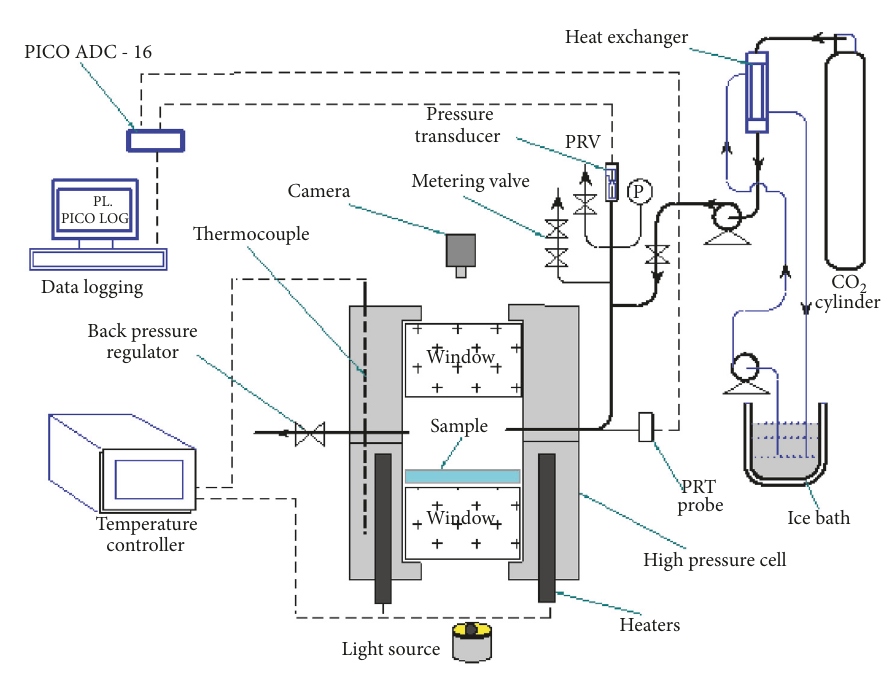
Figure 1: Experimental set-up showing connections to the viewing